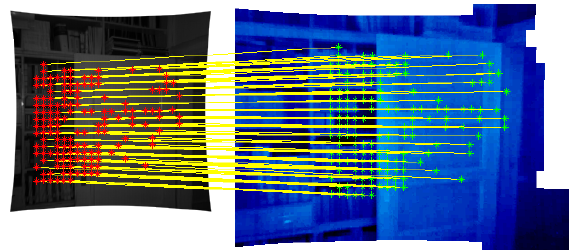
Figure 8: Automatically detected feature correspondences be- tween an intensity image and a thermal infrared image for a static scene.